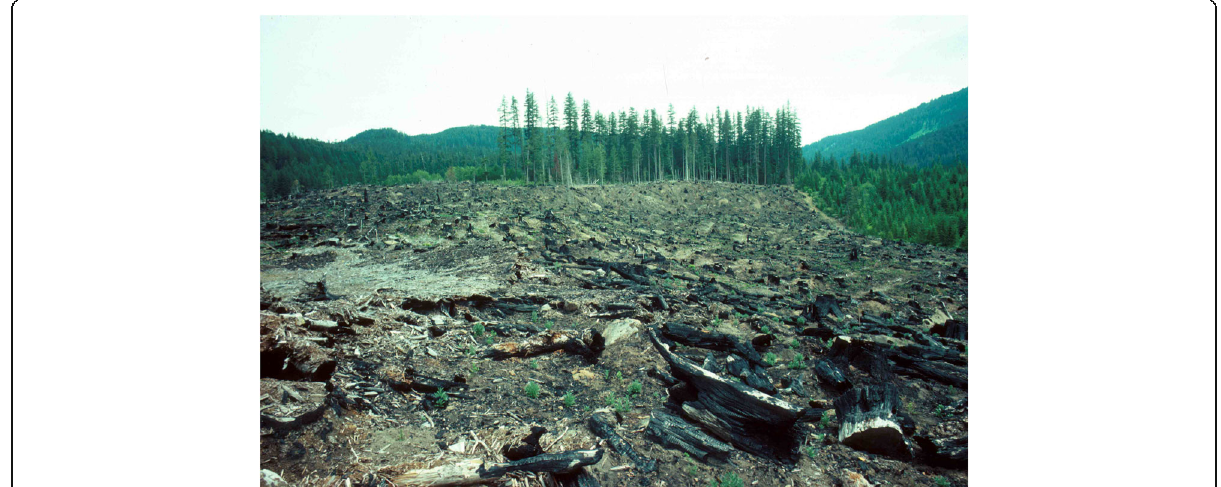
Fig. 1 Typical staggered-setting clear-cut in old-growth Douglas-fir forest on the Willamette National Forest (Oregon) in the late 1970s; note the high level of utilization and lack of significant slash after a broadcast burn of the site, which were considered to be evidence of good management